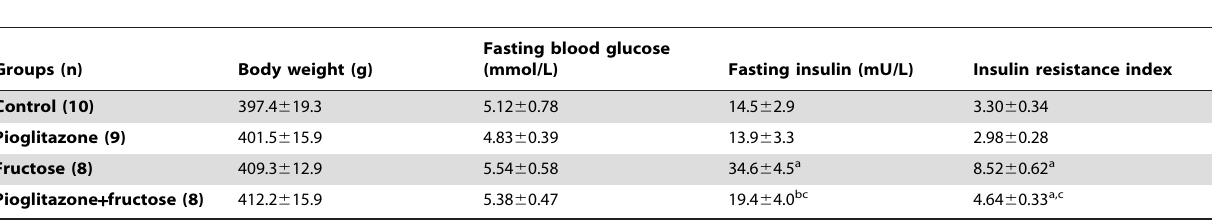
Table 1. Effects of pioglitazone on plasma glucose and insulin in fructose-drinking insulin resistance rats.